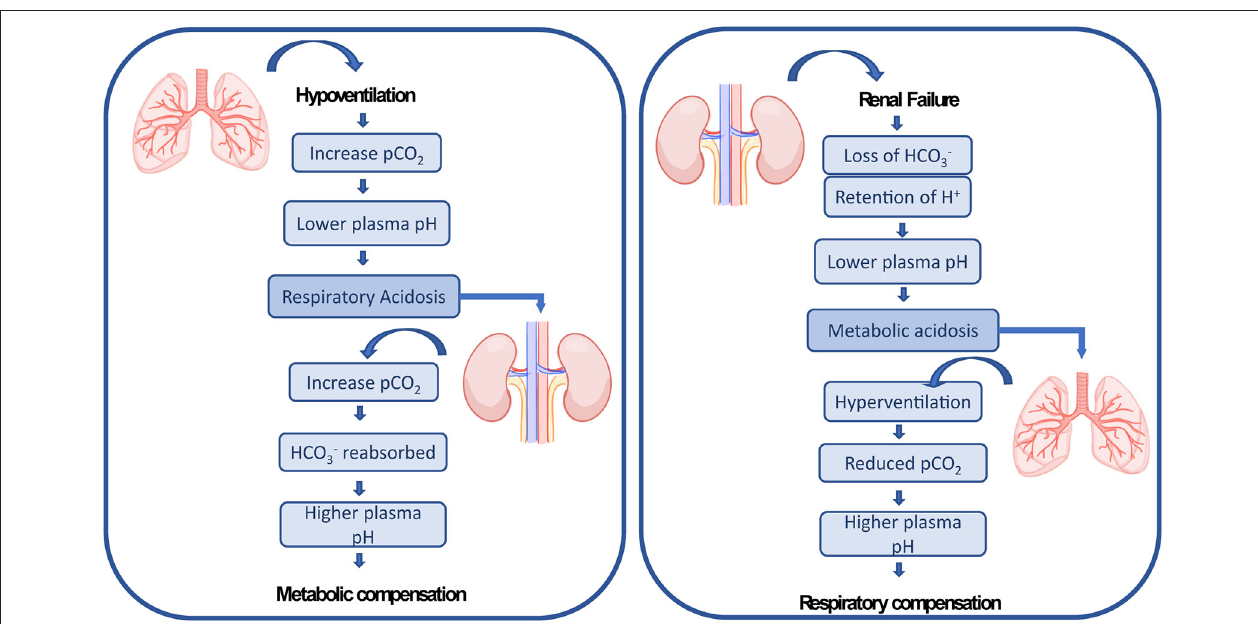
FIGURE 1 | The lungs and the kidneys cross-talk mechanism of renal compensation to pulmonary acidosis and pulmonary compensation to metabolic acidosis as explained by Sorino et al.